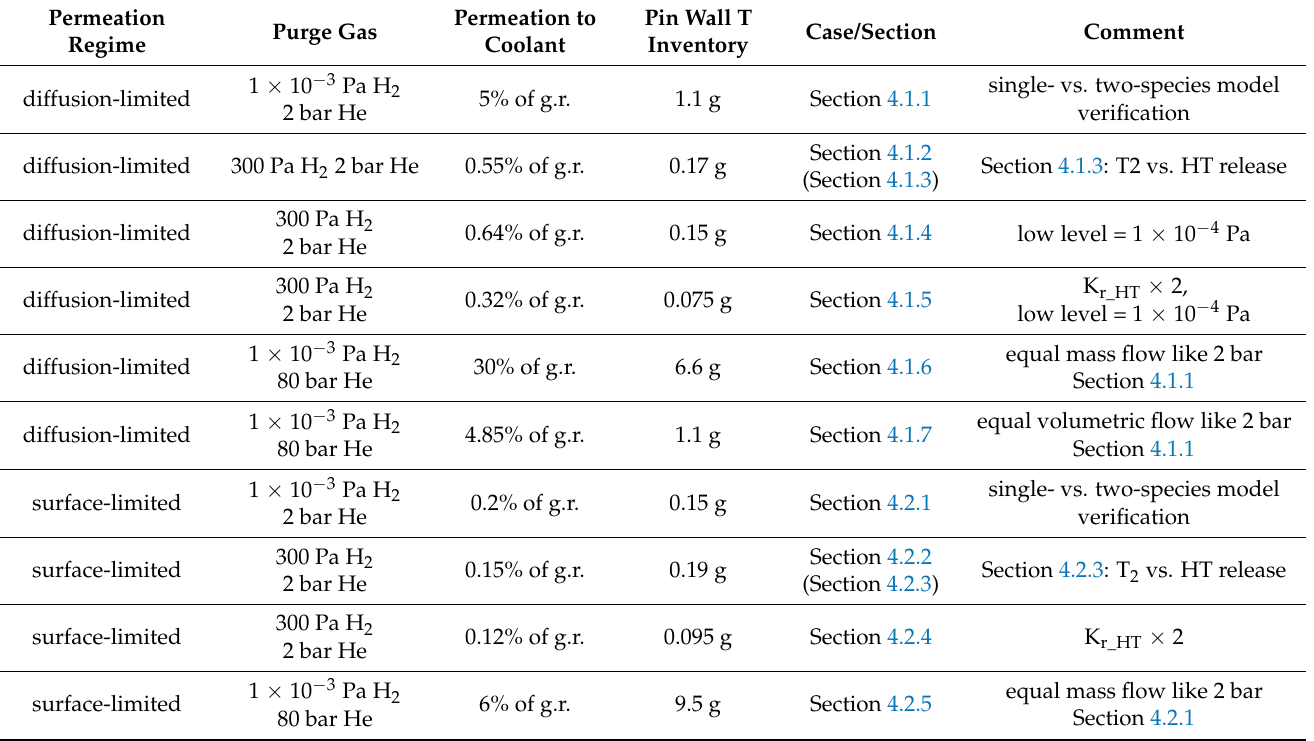
Table 2. Summary of permeation rates (% of T generation rate) and steel tritium inventories ( µ g/single pin) results for all cases of this